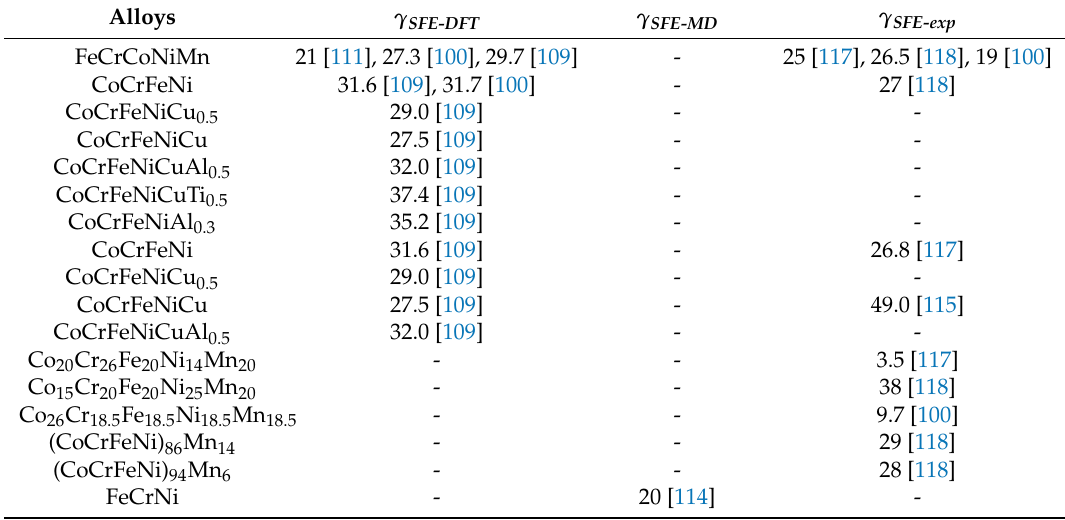
Table 2. A summary of available SFE (mJ/m 2 ) of MPE alloys in literature. Alloys γ SFE-DFT γ SFE-MD